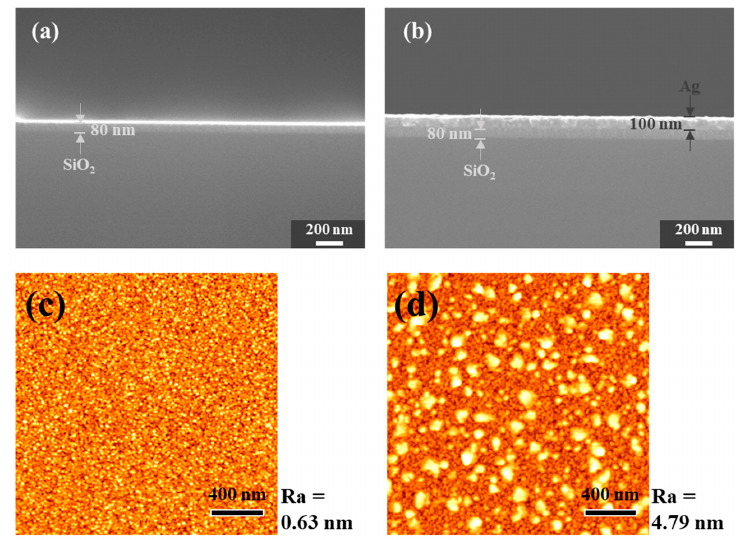
Figure 2. FESEM cross-section image of ( a ) SiO 2 and ( b ) Ag/SiO 2 deposited Si wafer; atomic force microscopy (AFM) 2D image of ( c ) SiO 2 and ( d ) Ag/SiO 2 layer.